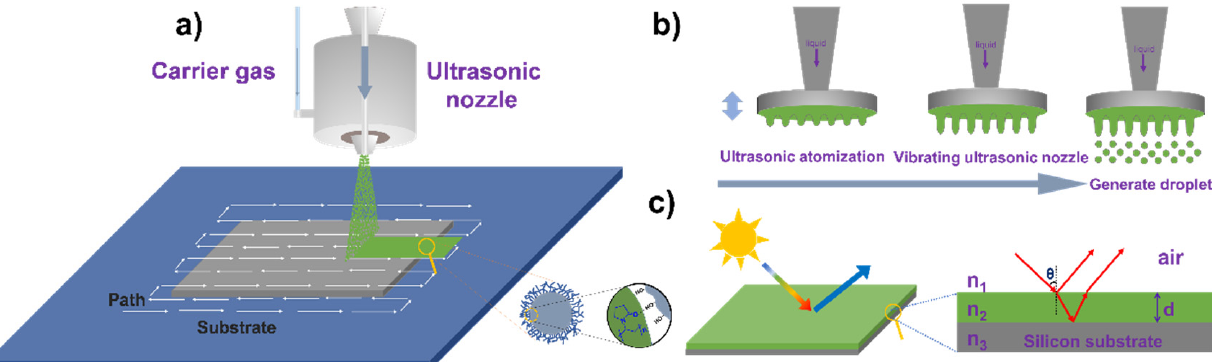
Figure 1. ( a ) Preparation scheme of structural color film with ultrasonic spray-coating technique, and schematic of PVP adsorption on the surface of silica particles. ( b ) The process of ultrasonic nozzle producing droplets. ( c ) Schematic of interference of the two reflected light waves from the air–film and film-silicon substrate. n 1 , n 2 , n 3 are the refractive indices of air, SiO 2 , and silicon substrate, respectively. d is the thickness of the SiO 2 /PVP film. θ is the incident angle.